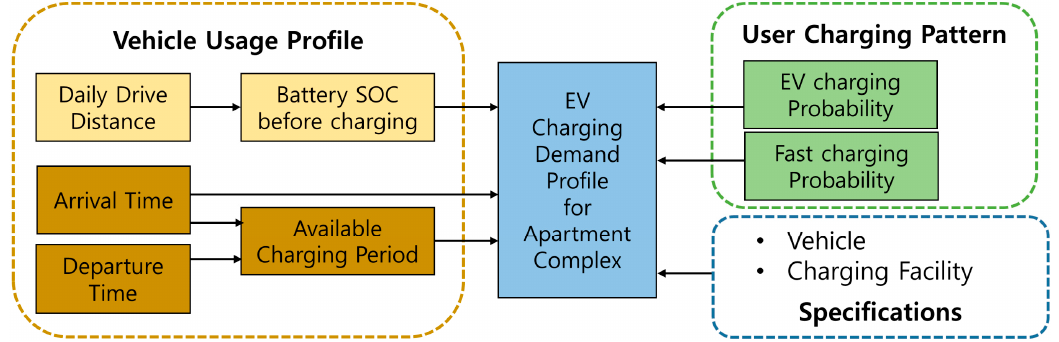
Figure 1. Diagram of Electric Vehicle (EV) charging demand estimation.